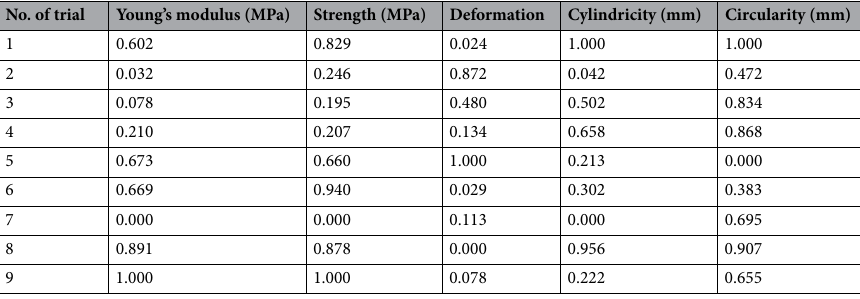
Table 5. Normalized